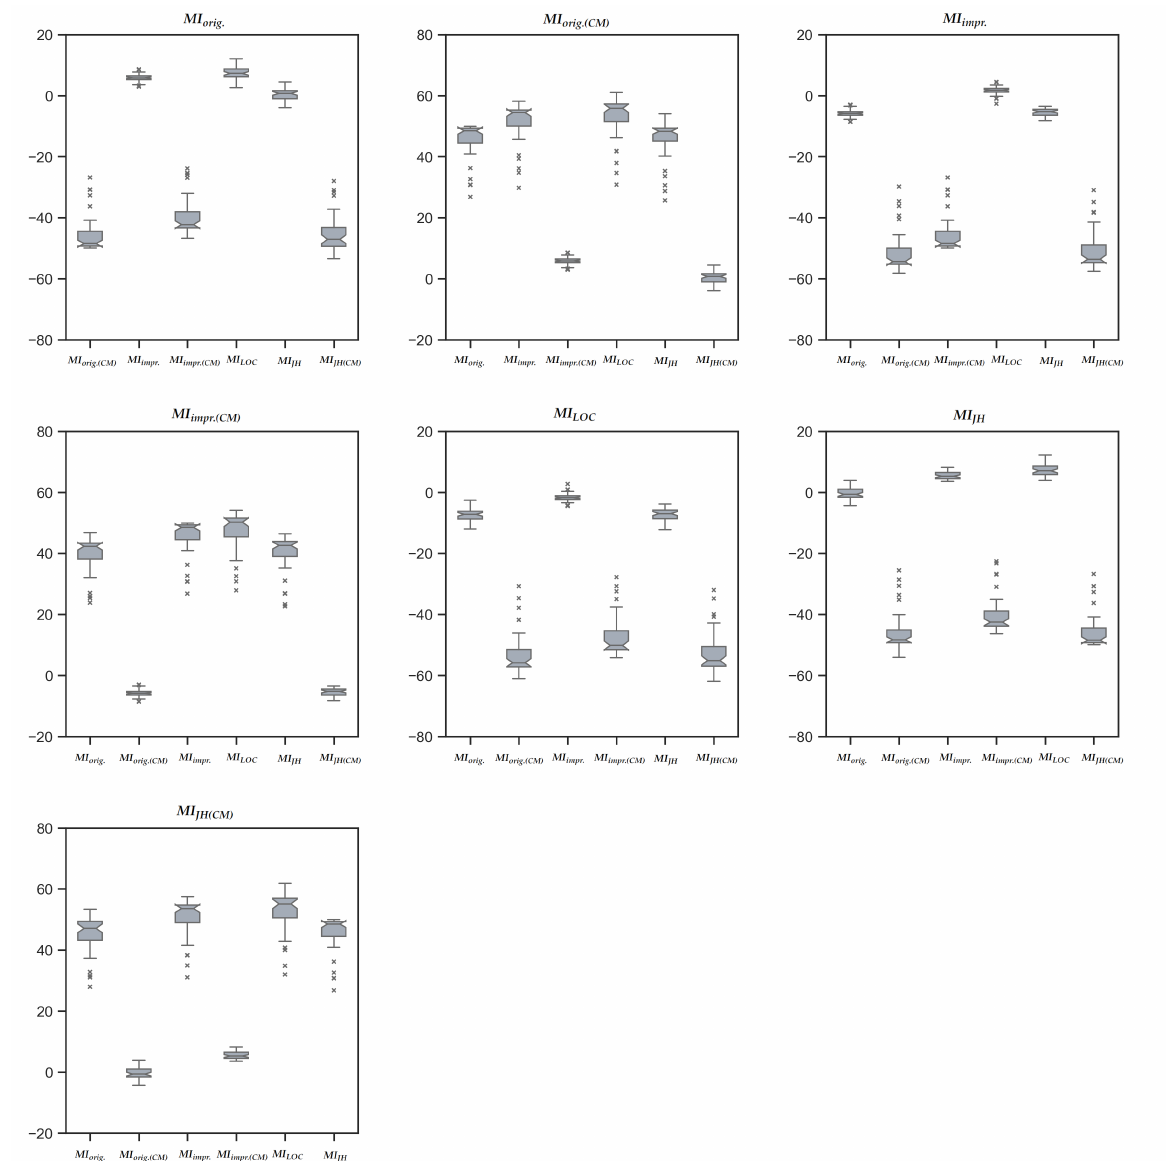
Figure 3. Boxplots of the pairwise differences between Index variant